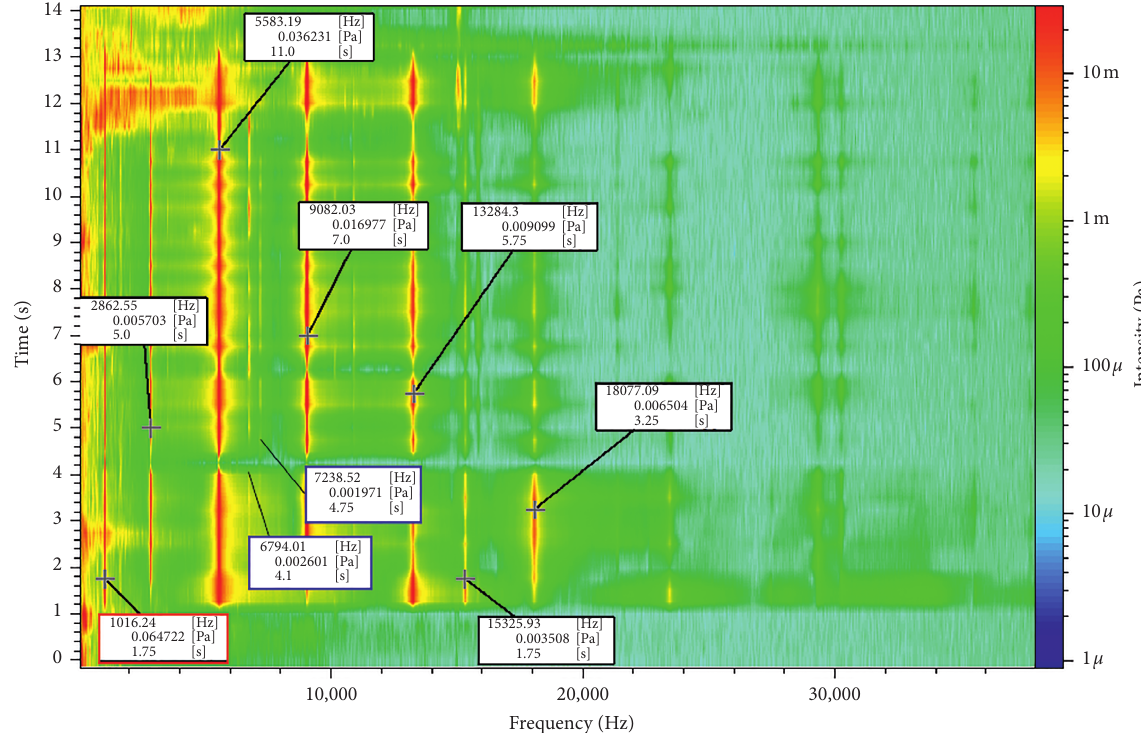
Figure 9: Spectrogram showing the IET test flexural frequency measurement as a function of time. Table 2: Calculated flexural and torsional modes for positions A and B with initial estimates of elastic properties ( E � 208GPa and ] � 0.22). Specimen